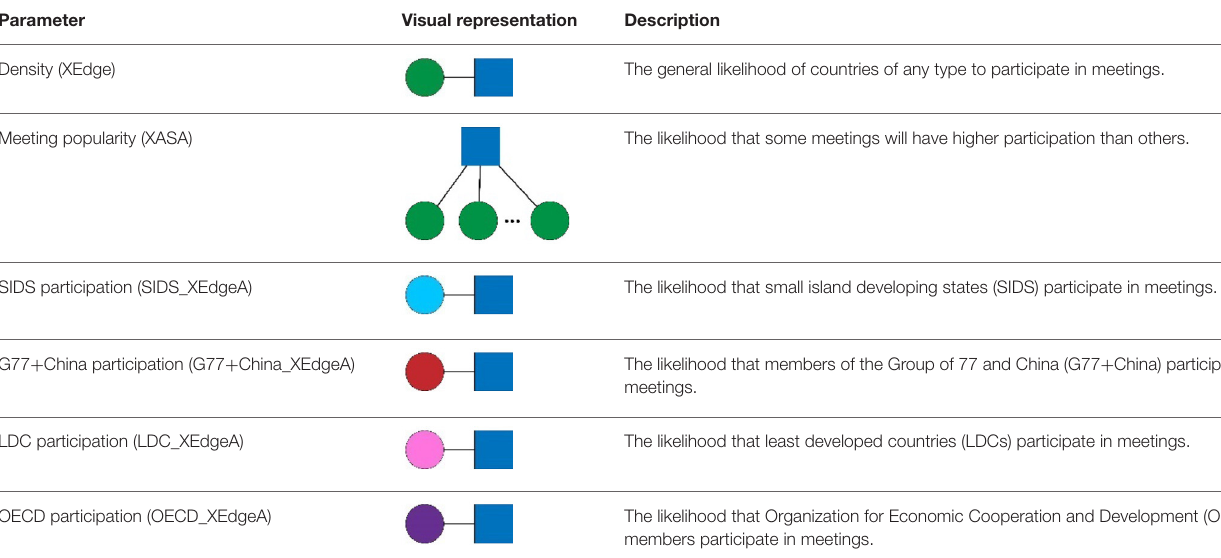
TABLE 2 | Focal parameters in the exponential random graph modeling.